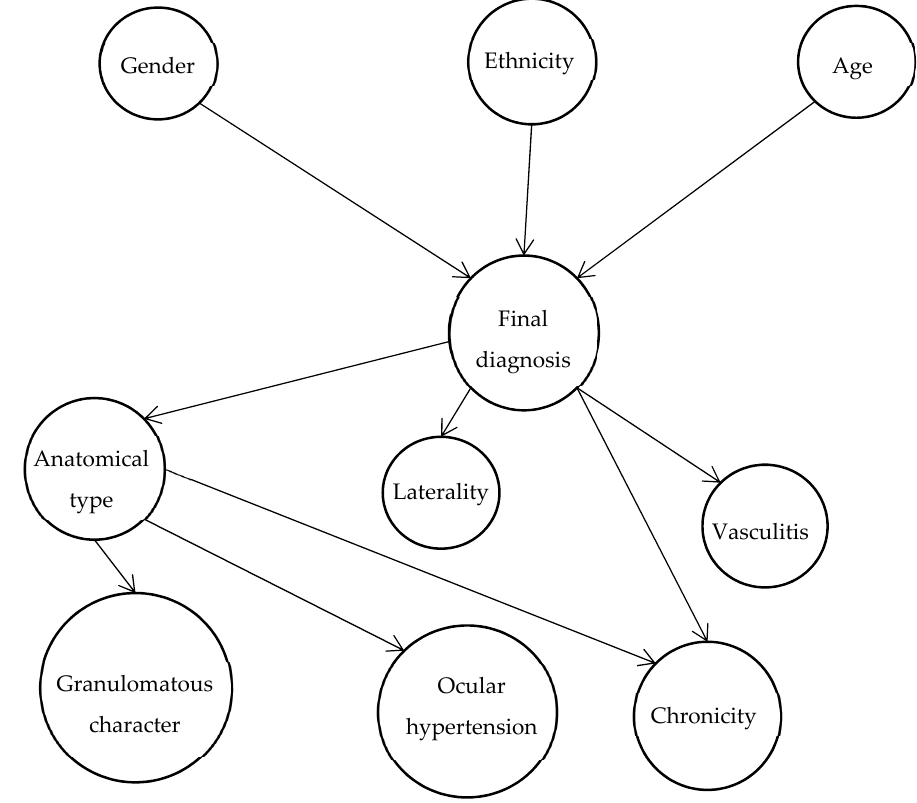
Figure 2. Structure of the Bayesian network for etiologic diagnosis of uveitis.